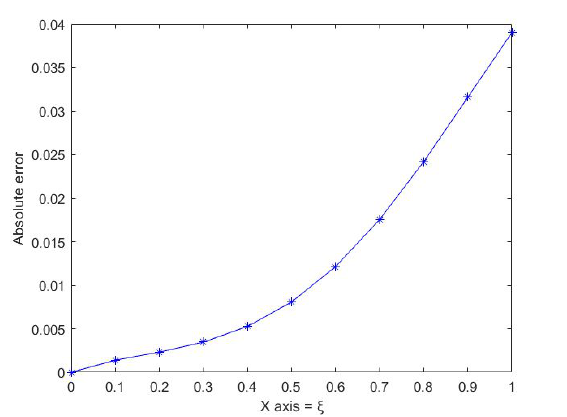
Figure 2. The absolute error with an interval difference of 0.1 for Example